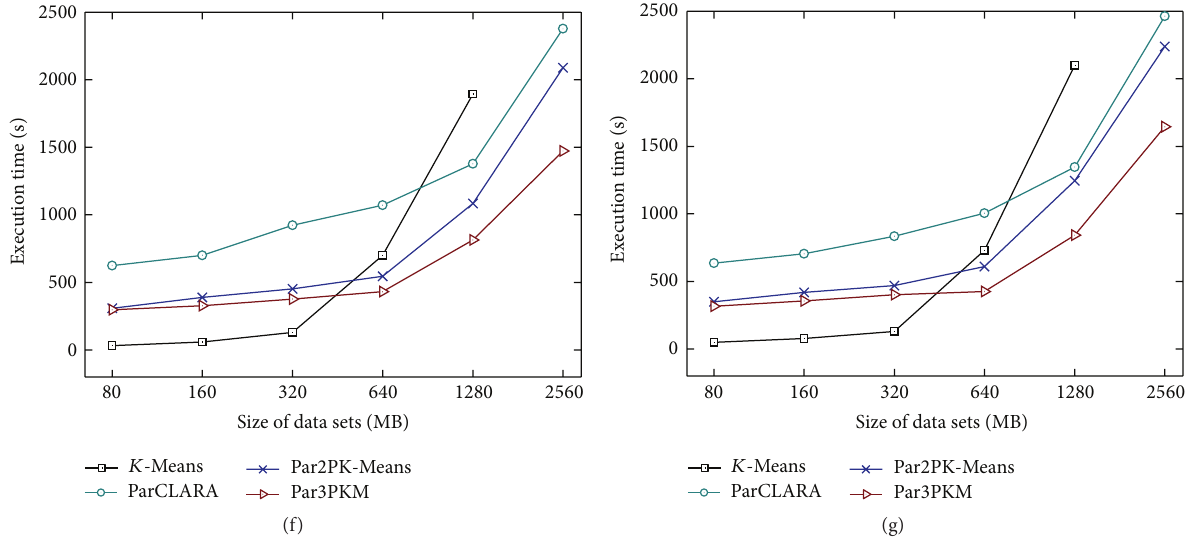
Figure 11: Efficiency comparison on different data sets. (a) Taxi Trajectory, (b) Iris, (c) Haberman’s Survival, (d) Ecoli, (e) Hayes-Roth, (f) Lenses, and (g) Wine.